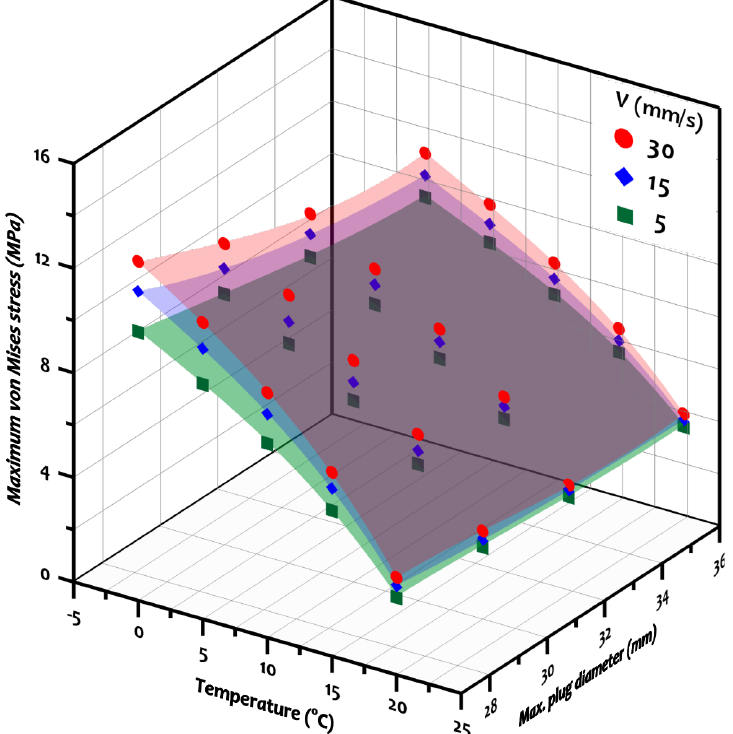
Figure 20. Surface plots illustrating the effects of the variables on the maximum von Mises stress. Table 5. Determined coefficients of proposed equation.